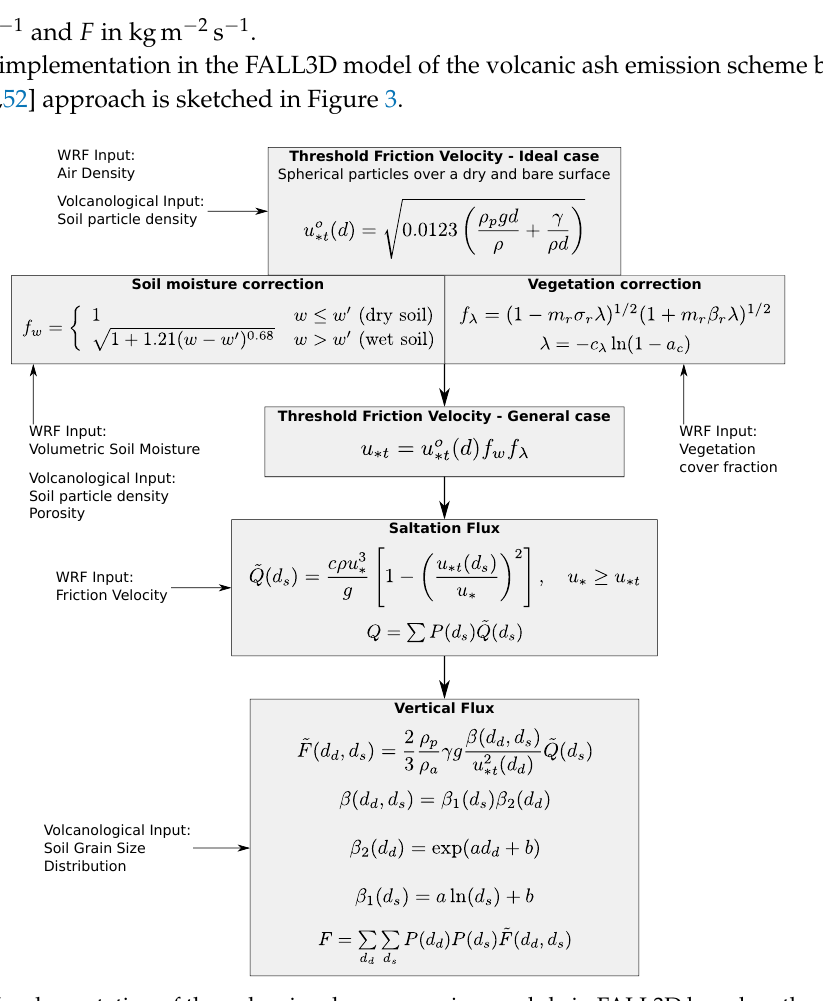
Figure 3. Implementation of the volcanic ash resuspension module in FALL3D based on the original dust emission scheme by Shao et al. [51,52]. The parameterisations and the required input data are detailed along with the procedure to compute the emission